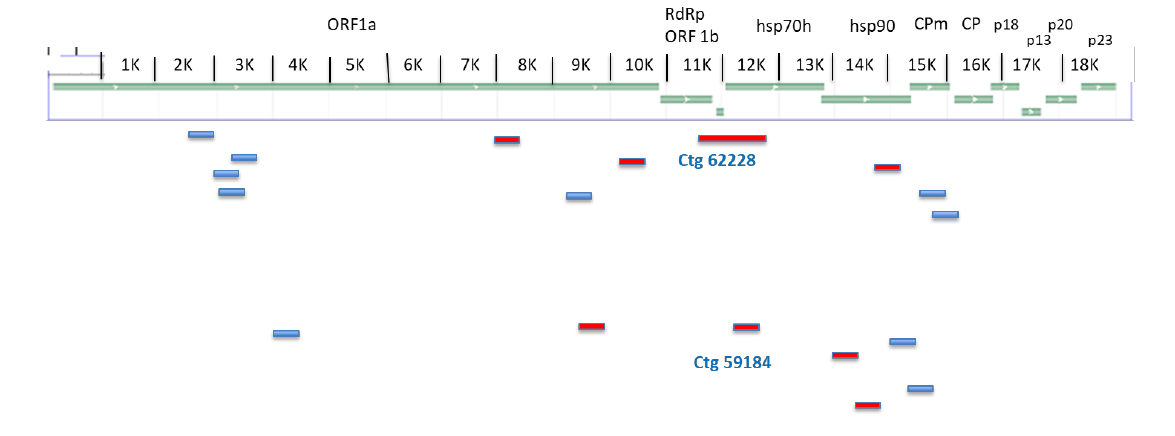
Figure 1. A graphic representation of the distribution, along a generalized closterovirus genome, of the contigs obtained in the two Illumina sequenced libraries for VdN and VCC accessions. ORFs names are indicated above the genome: RdRp: RNA-dependent RNA polymerase; hsp: Heat Shock Protein; CPm: Coat Protein minor; p: protein. Only the major contigs are reported; the size is not in scale. Contigs used for the primer design and RT–PCR validation on fig RNA extracts are in red. The codes for the two contigs (VCC 62228 and VdN 59184) overlapping at the 5 (cid:48) of HSP70h gene are